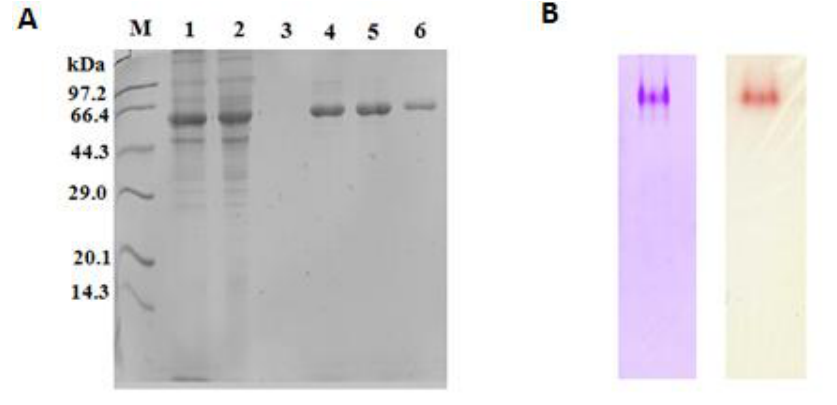
Figure 3. Purification of Lip5-DM from the culture supernatant ( A ) and activity staining ( B ) A Lane M: molecular weight marker; lane 1: Culture supernatant; lane 2: Concentrated supernatant after (NH ) SO precipitation; lane 3: Fraction sample eluted from column by 4 2 4 100 mM NaCl; lane 4–6: Fraction samples eluted from Q Sepharose TM Fast Flow by 200 mM NaCl. B. Zymogram analysis of purified Lip5-DM (1.4 μg) was performed with β-naphtyl acetate as substrate. The gels were stained by Coomassie Brilliant Blue (left) and (right) Fast Blue